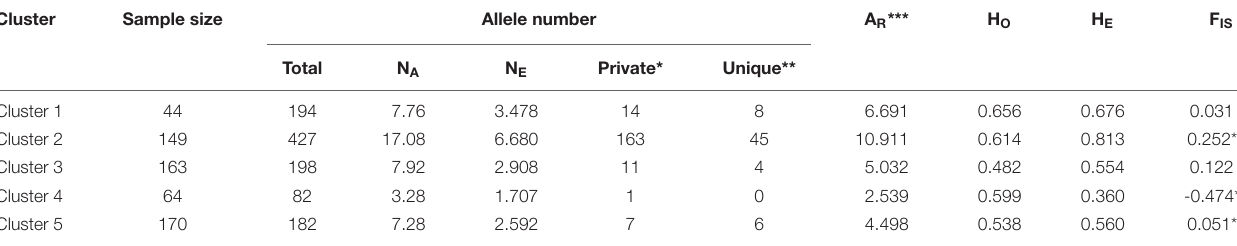
TABLE 3 | Descriptive information for each of the five clusters of genotypes identified by STRUCTURE analysis. Cluster Sample size Allele number A R *** H O H E F IS Total N A N E Private* Unique**